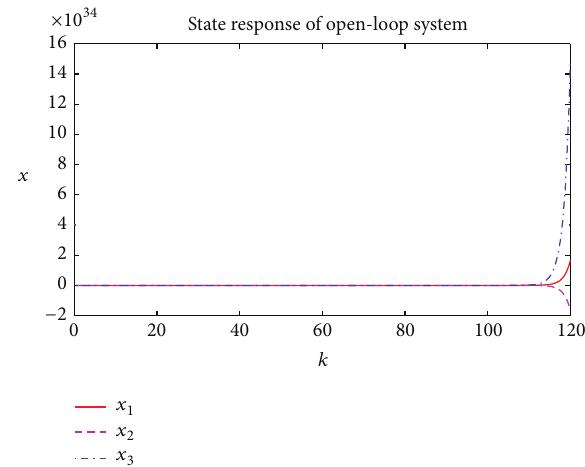
Figure 1: State response of open-loop